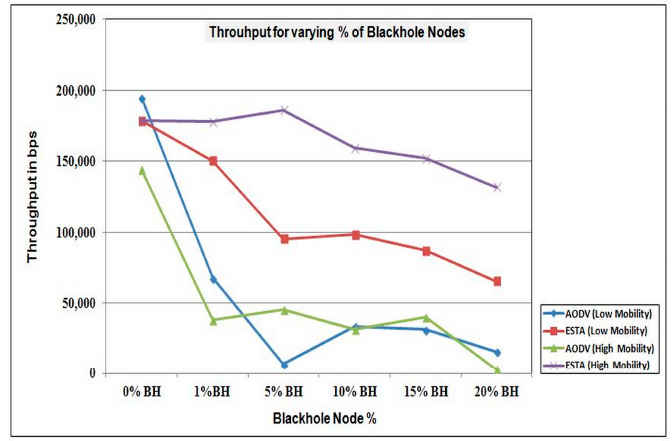
Figure 12. Throughput for varying % of Blackhole nodes and mobility.